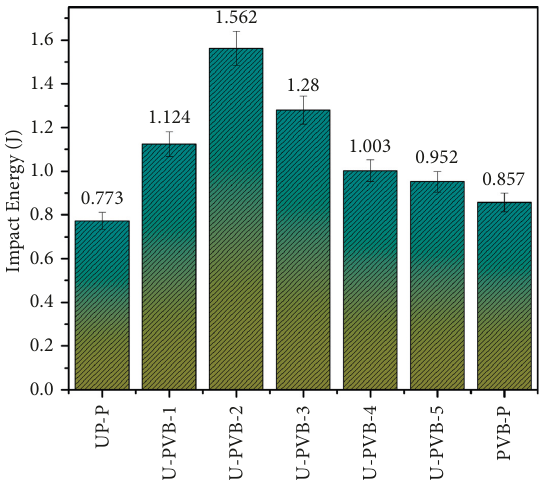
Figure 12: Change in impact energy with respect to increase in PVB content.